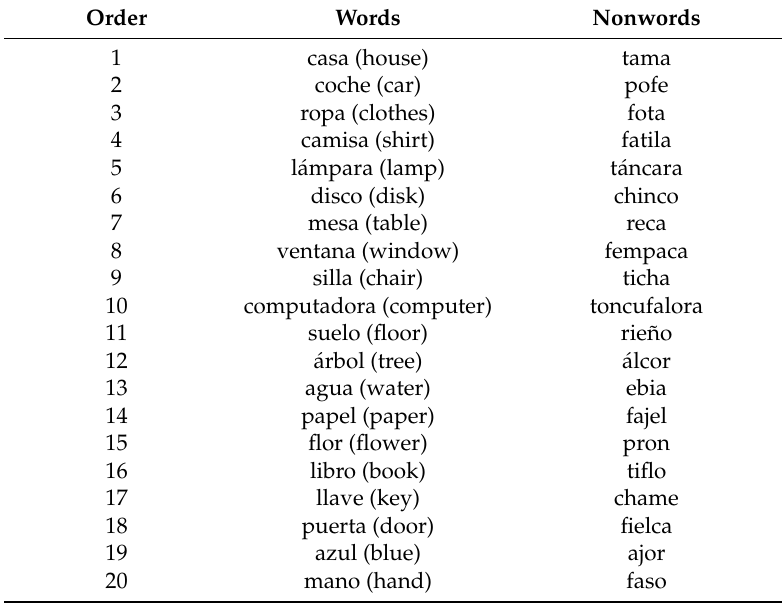
Table A2. Words and nonwords used in the